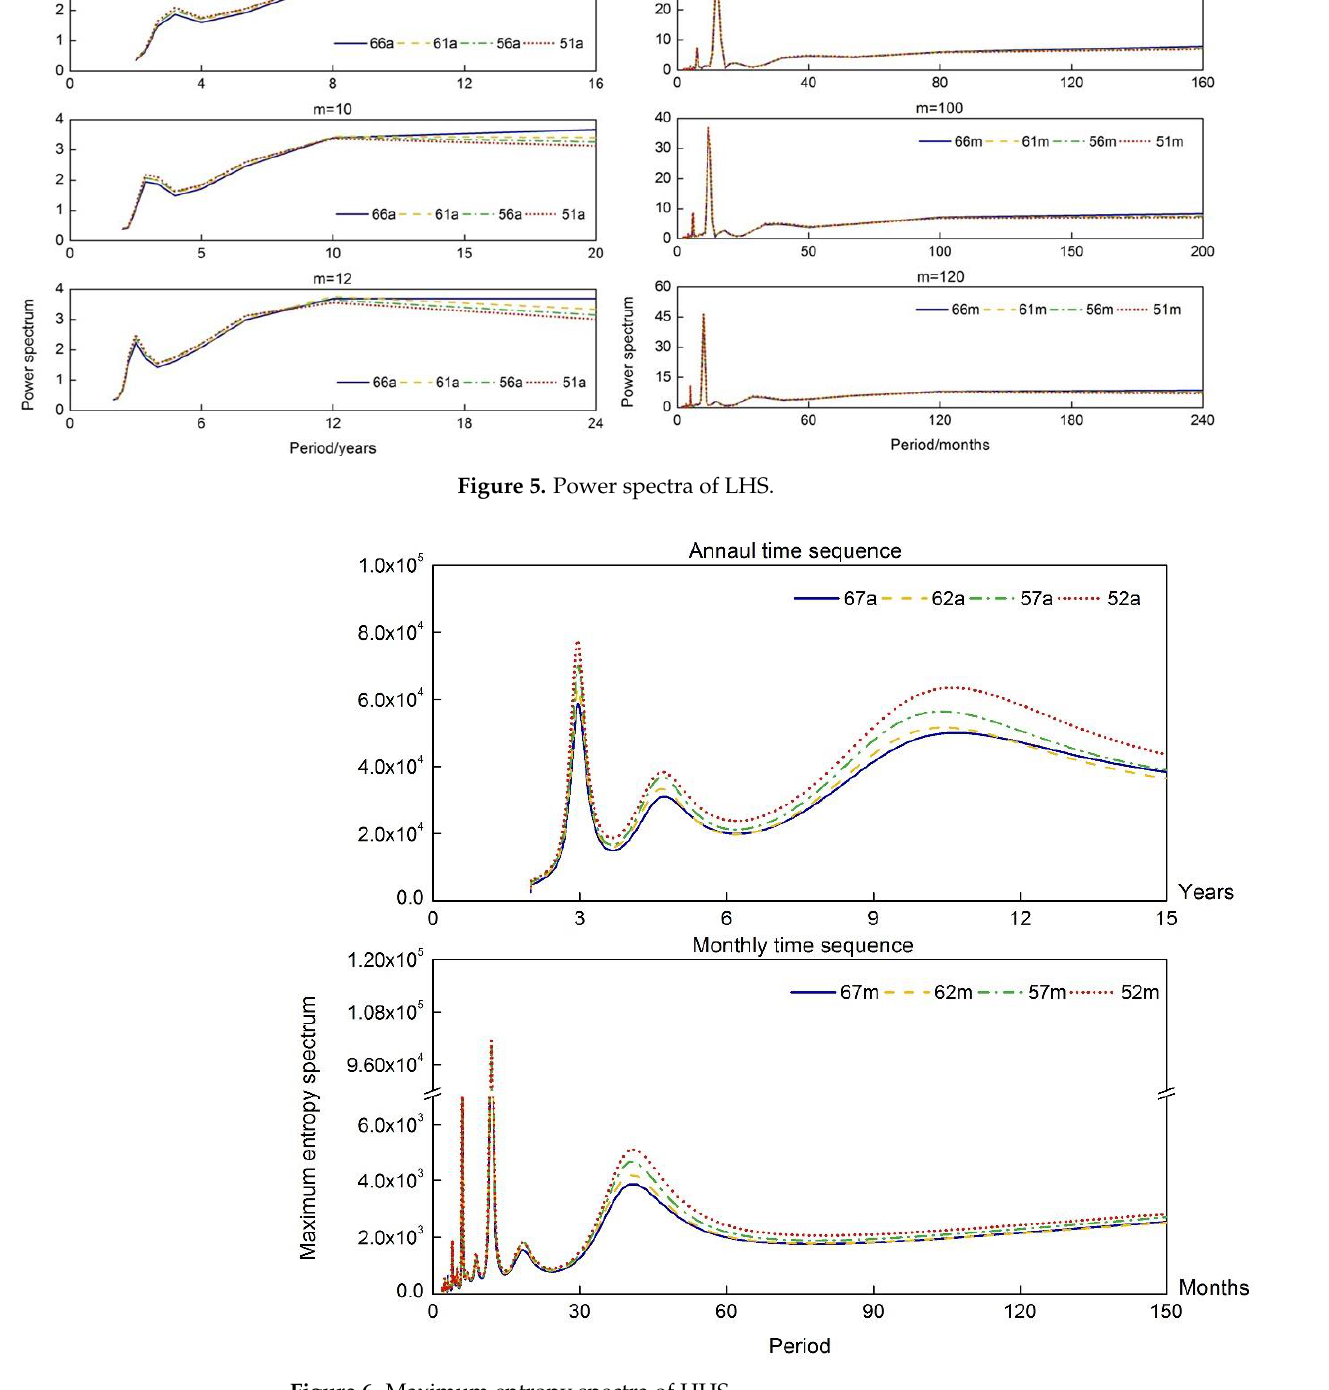
Figure 6. Maximum entropy spectra of HHS.